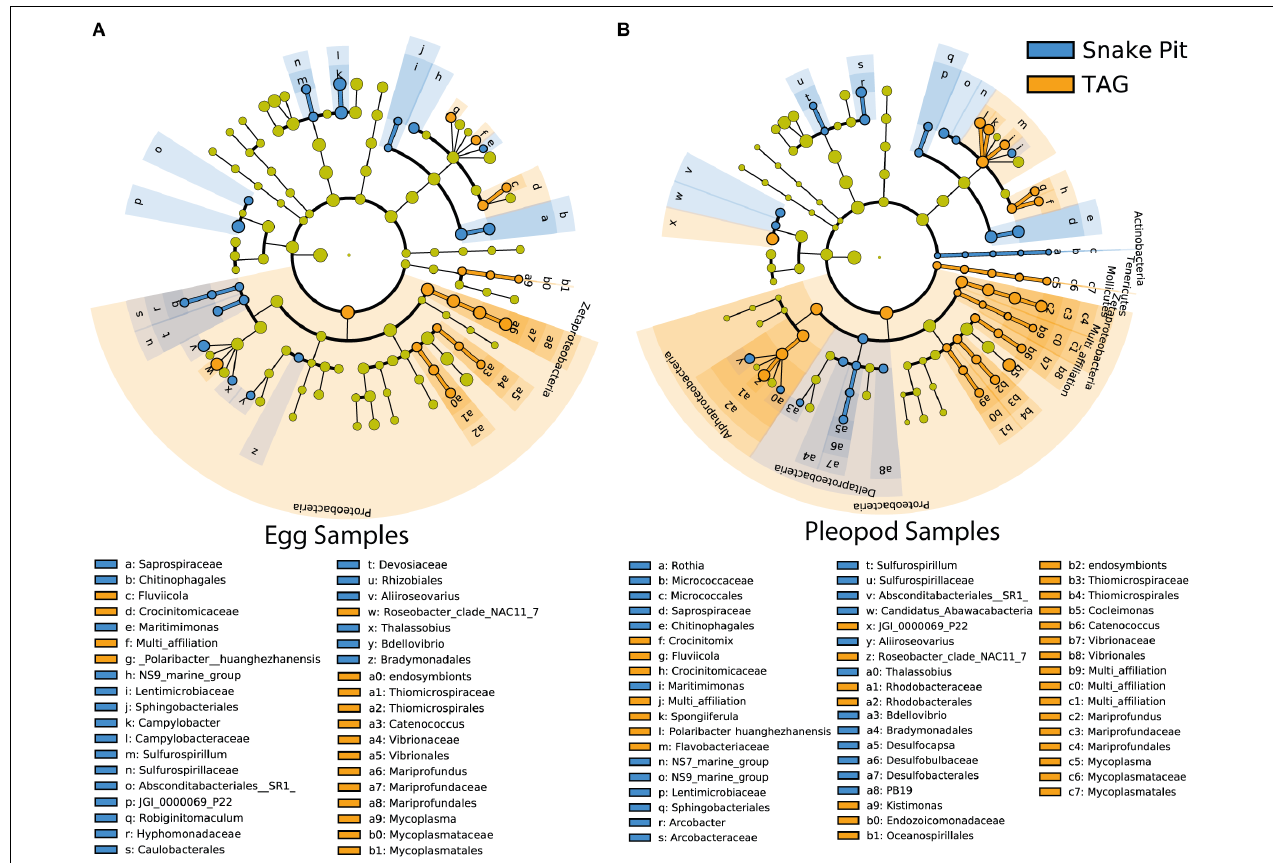
FIGURE 5 | Most differentially abundant taxa of egg communities (A) and pleopod communities (B) between TAG (orange) and Snake Pit (blue) vent fields. The dots represent the specific bacterial taxa, with colors corresponding to the vent field where these are relatively more abundant, yellow-greenish color denoting taxa with no significant difference in relative abundance between vent fields. The size of dots is proportional to the relative